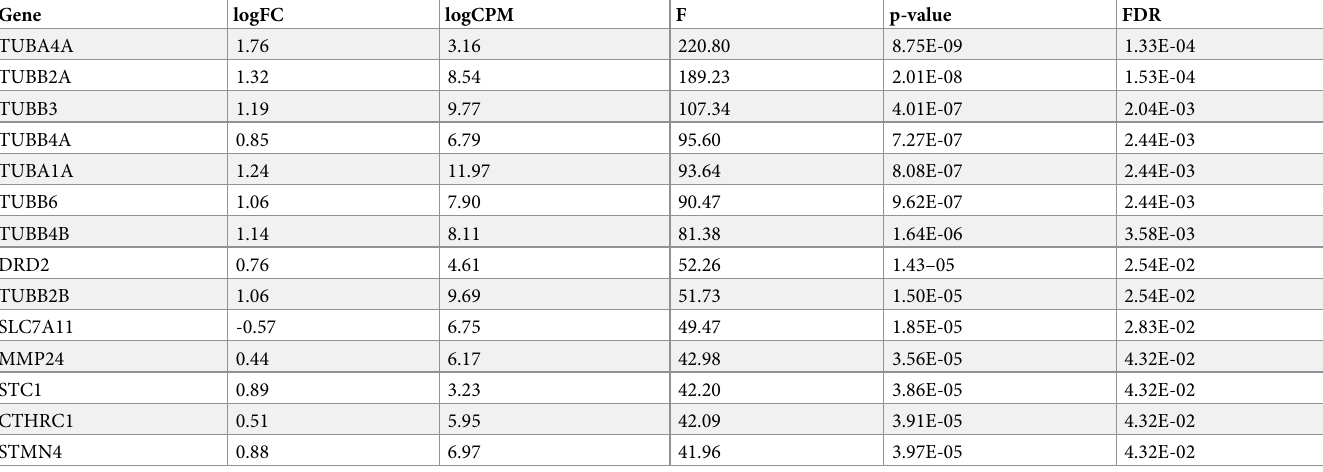
Table 2. Differential gene expression of paclitaxel-treated si SBF2 iPSC-dSN. Comparison between paclitaxel and vehicle treatment (FDR < 0.05). Gene logFC